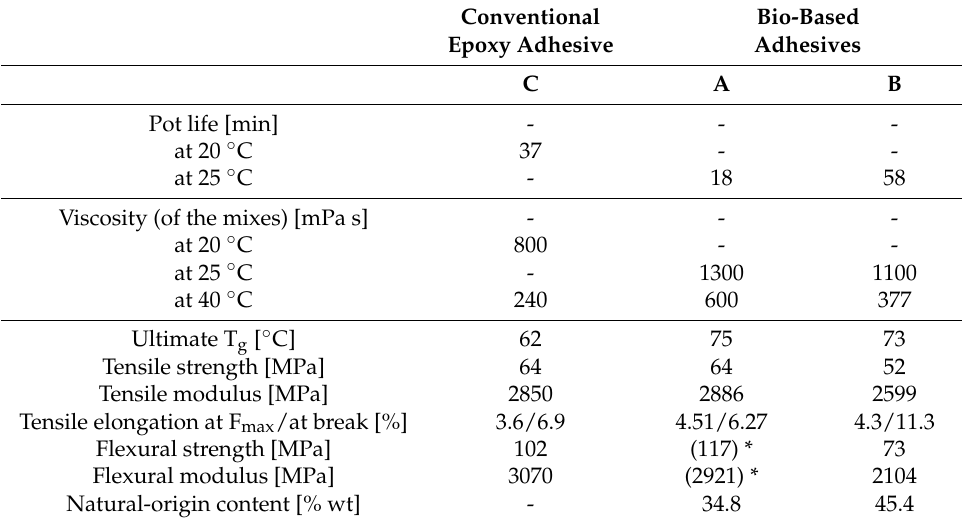
Table 2. Properties of the investigated